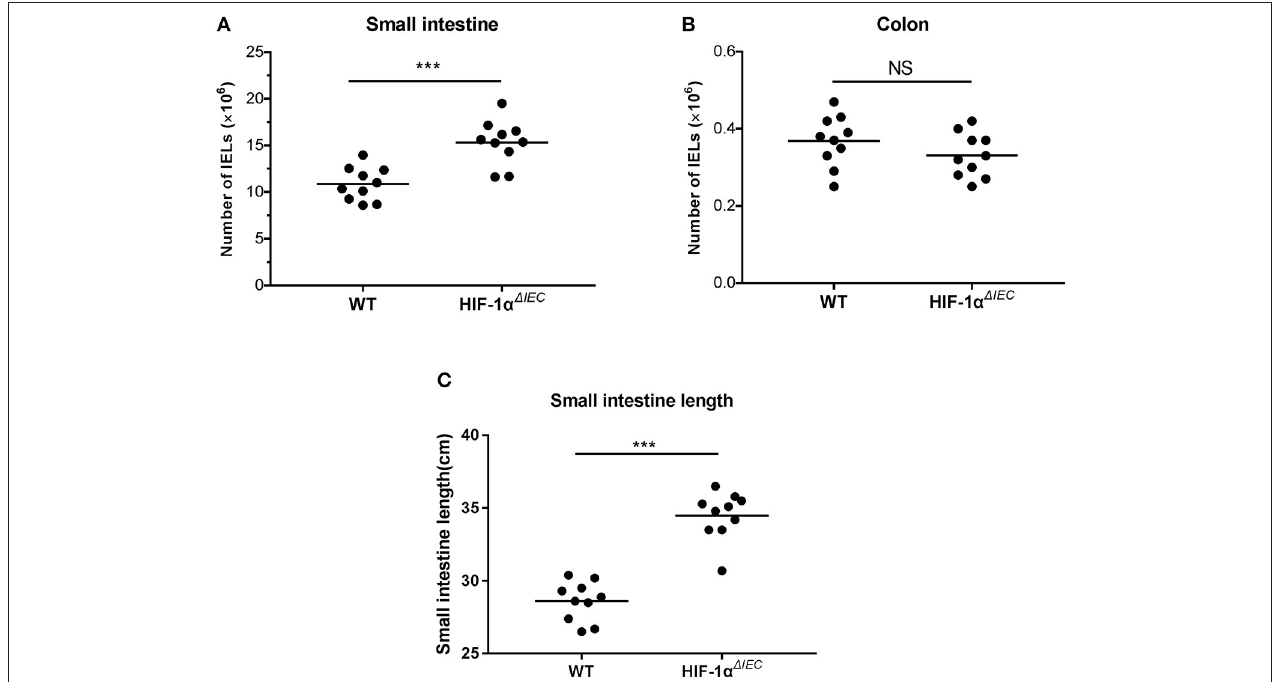
FIGURE 2 | Changes in the number of intraepithelial lymphocytes (IELs) in Hif1- α ∆ IEC mice. The numbers of IELs in the small intestine (A) and colon (B) of Hif1- α ∆ IEC mice and individual control mice. (C) The length of small intestine from WT or Hif1- α ∆ IEC mice ( n = 10 mice/group). *** P < 0.001; NS, not